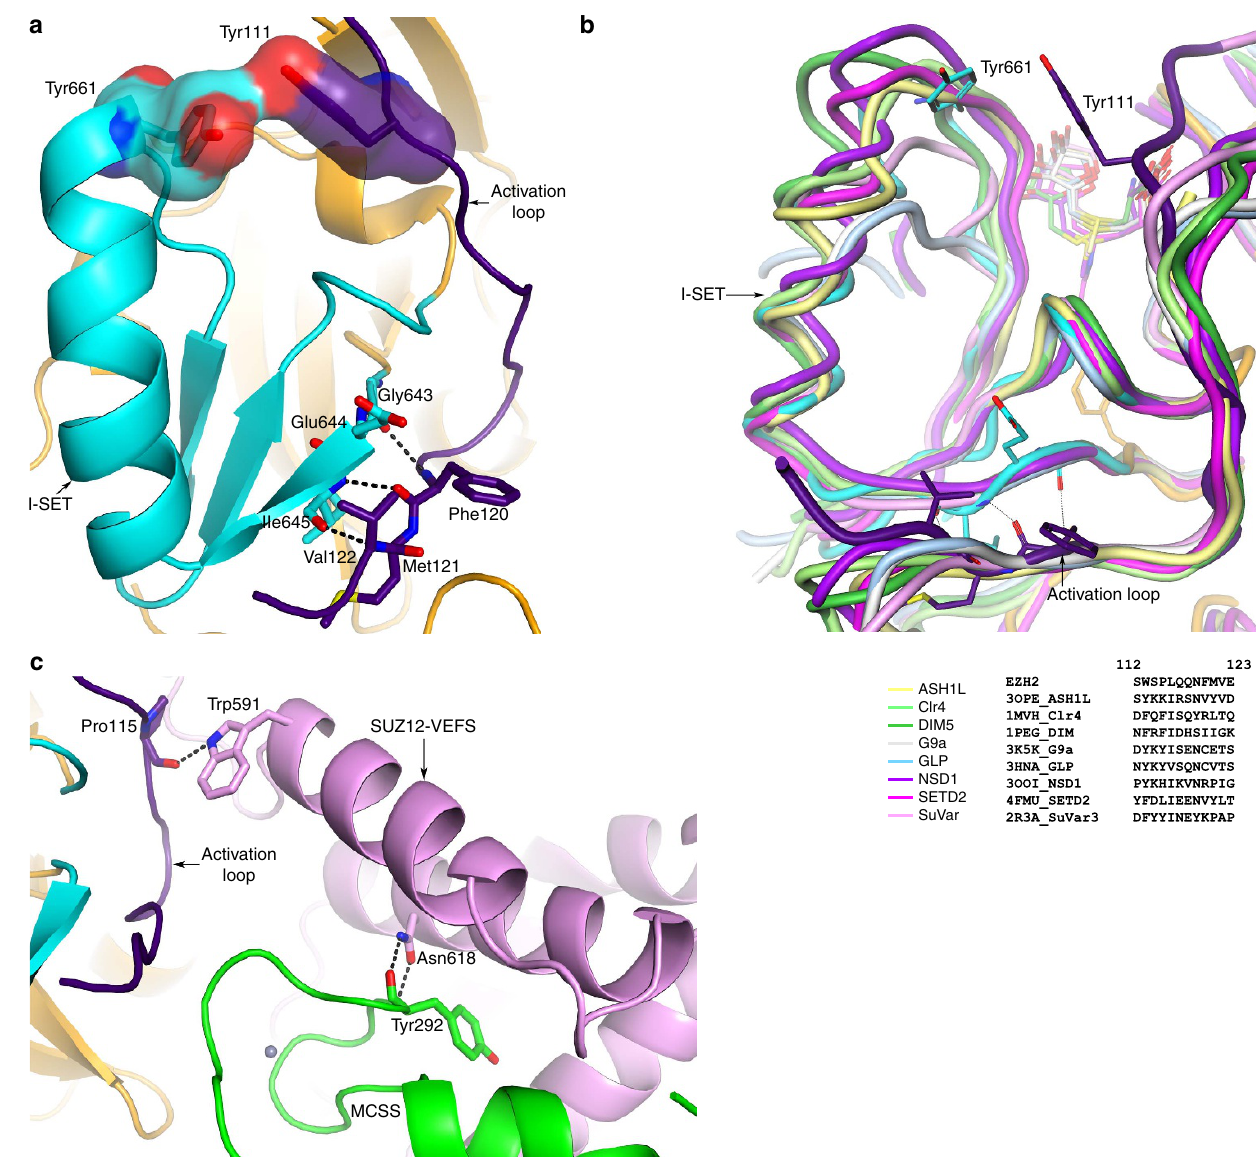
Figure 5 | Stabilization of the active SET domain by the activation loop. ( a ) Activation loop may induce the SET domain conformational change via specific backbone (bottom) and non-specific sidechain (top) interactions with I-SET. I-SET (Gly643–Gly681) is highlighted in cyan, the rest of the SET domain is shown in orange and the activation loop is shown in indigo. ( b ) Structural alignment of lysine methyltransferase SET domains with PRC2 SET domain shows structural conservation of the activation loop, with divergent sequences. Structure-based sequence alignment of this region shows poor overall sequence similarity. ( c ) Role of SUZ12-VEFS (shown in pink) in the stimulation of PRC2. Patient-derived SUZ12 mutations, W591C and N618Y abrogate favourable interactions, impacting the PRC2 activity/integrity. Colour code is same as in Fig.